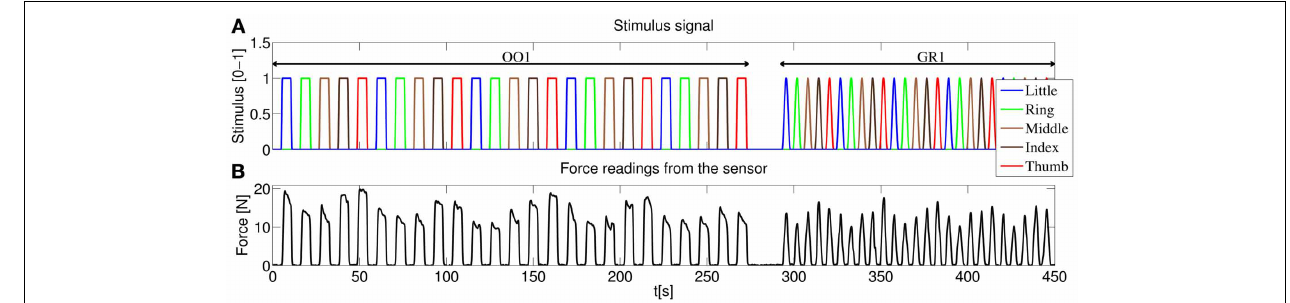
FIGURE 4 | (A) Structure of the stimulus shown to the subjects, first session. In the on-off phase (OO1), only rest and maximum force are induced for each finger, each repetition consisting of 4.5s of force application, followed by 4.5s